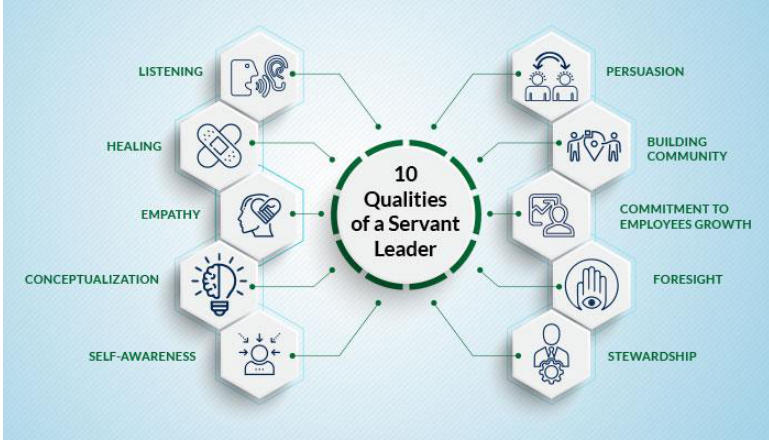
Figure 3. Ten characteristics of a servant leader [63].